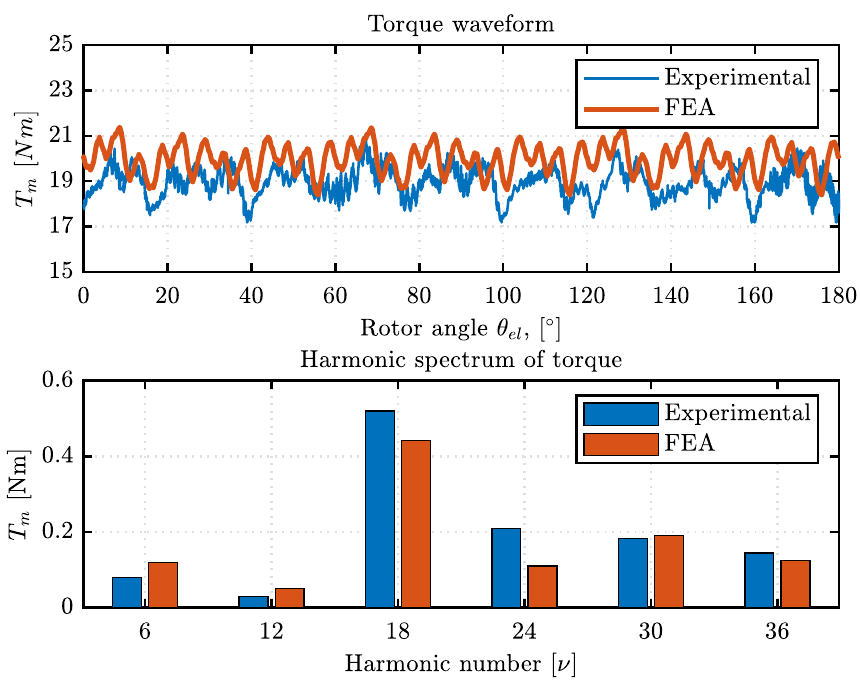
Figure 11. Torque ripple: waveforms and harmonics comparison.